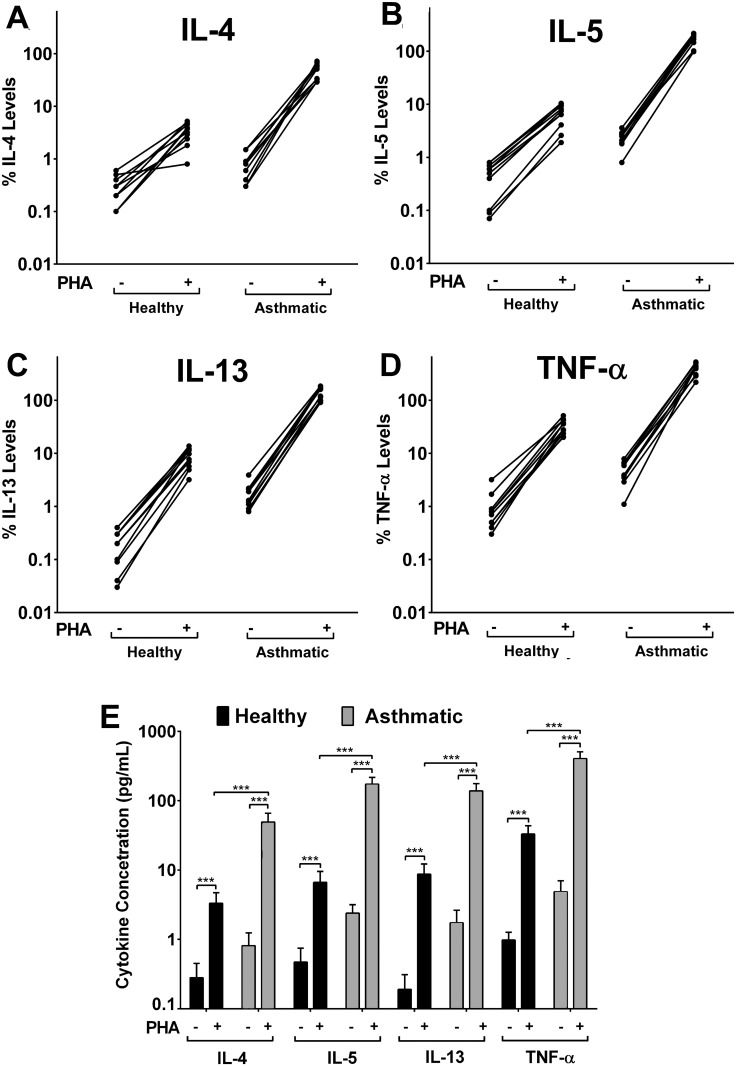

Ex-vivo cytokine release.PHA-induced release of IL-4, IL-5, IL-13 and TNF-α in PBMC culture supernatants of healthy (n = 10) and mild asthmatic (n = 10) subjects (A to D). Error bars are omitted for reasons of clarity. (E) Summary of the results from A to D. Each sample was analysed in triplicate. Error bars indicate the standard deviation. ***p<0.001 versus PHA-stimulated control.